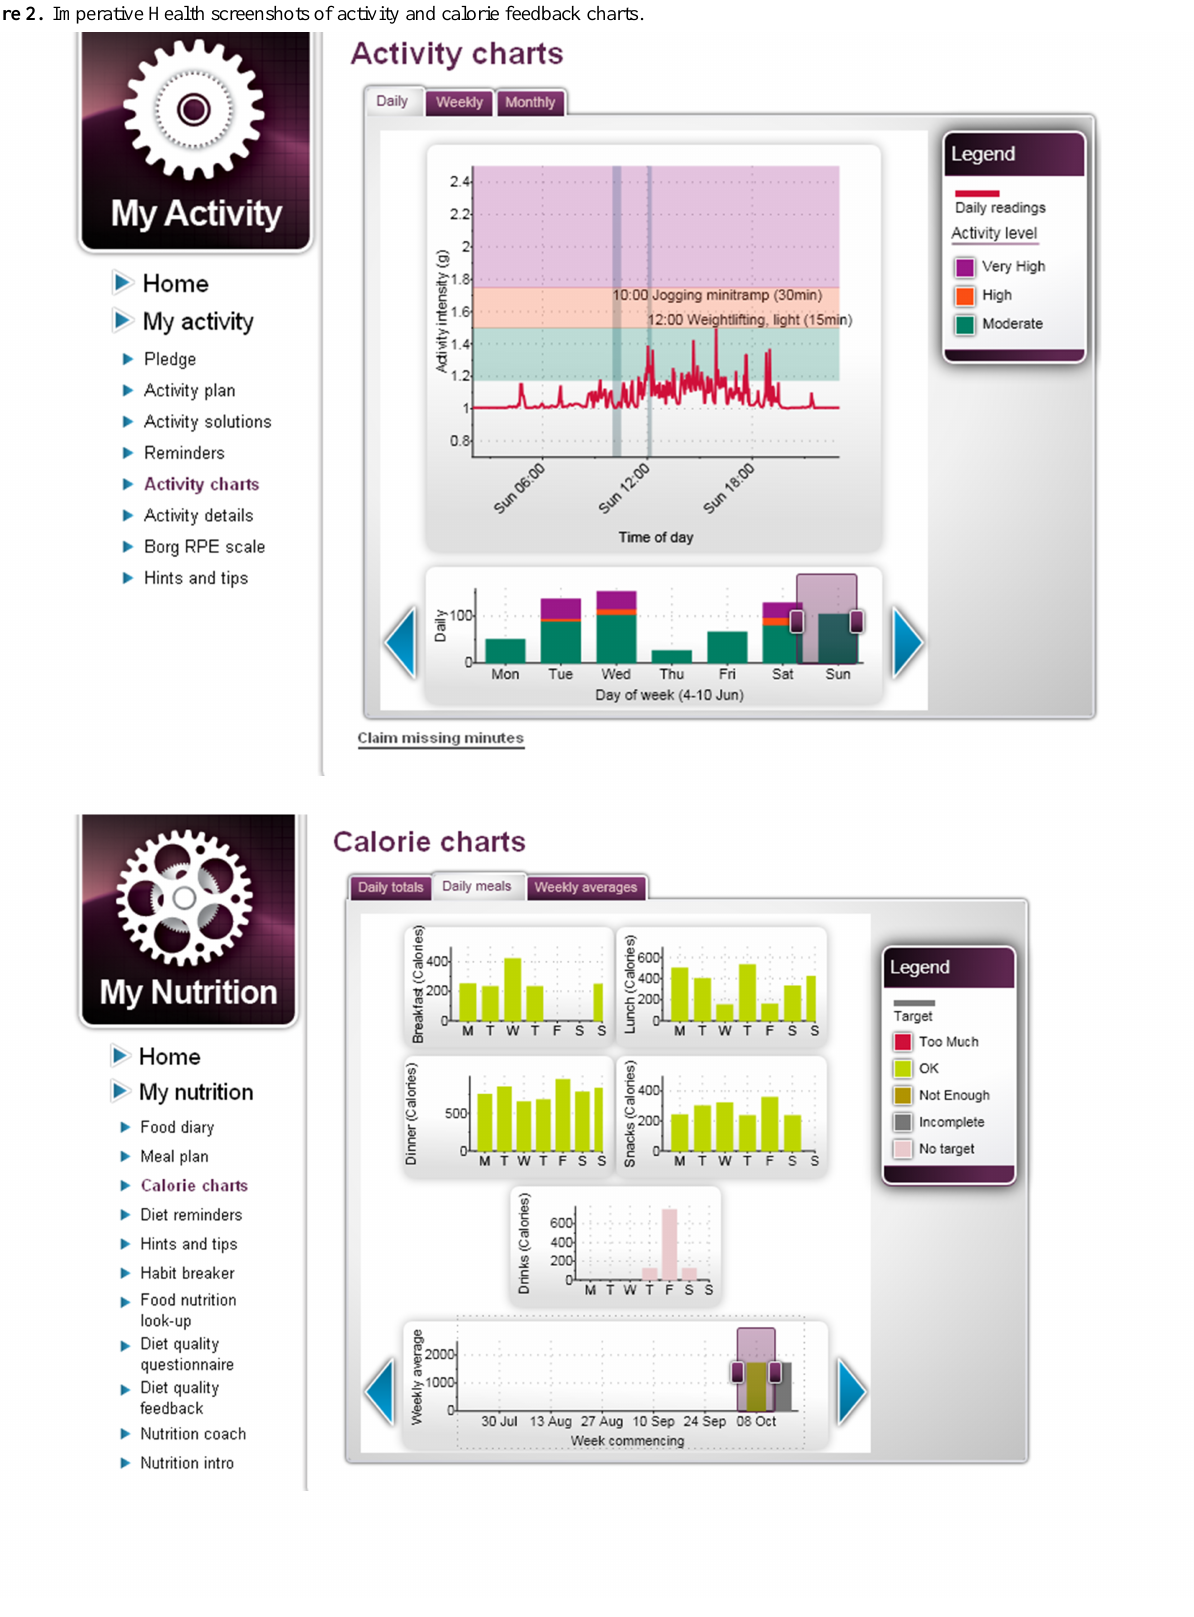
Figure 2. Imperative Health screenshots of activity and calorie feedback